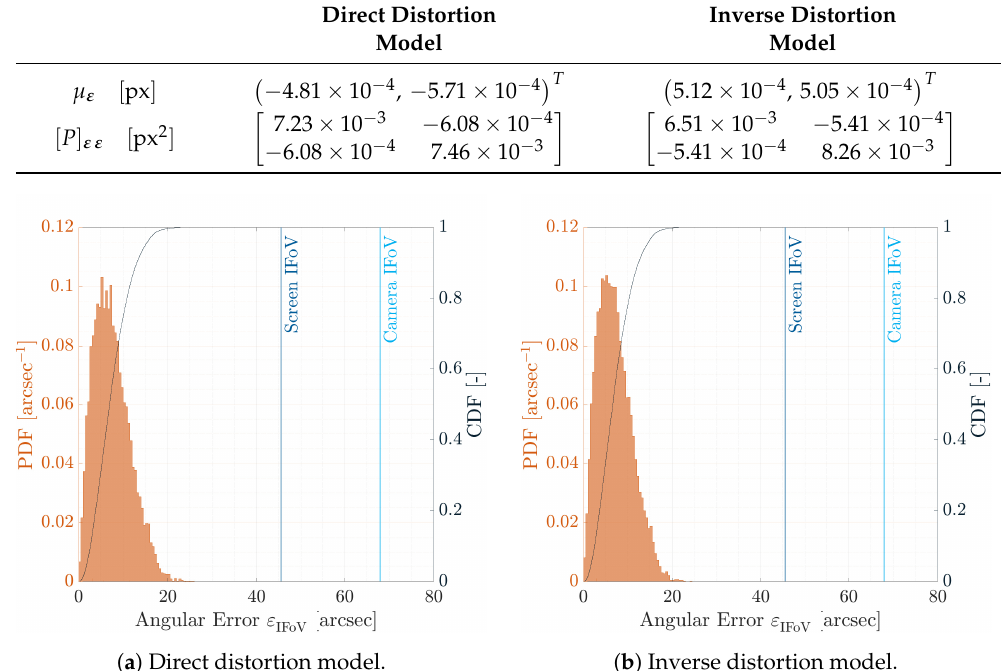
(cid:0) (cid:1) T ε x , ε y for the two proposed distortion models.